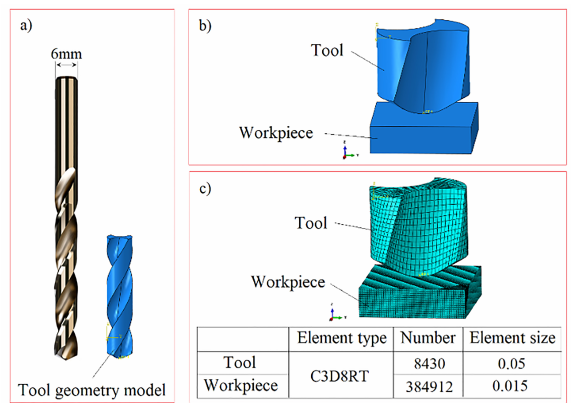
Table 4. J-C model of AA2024 aluminium